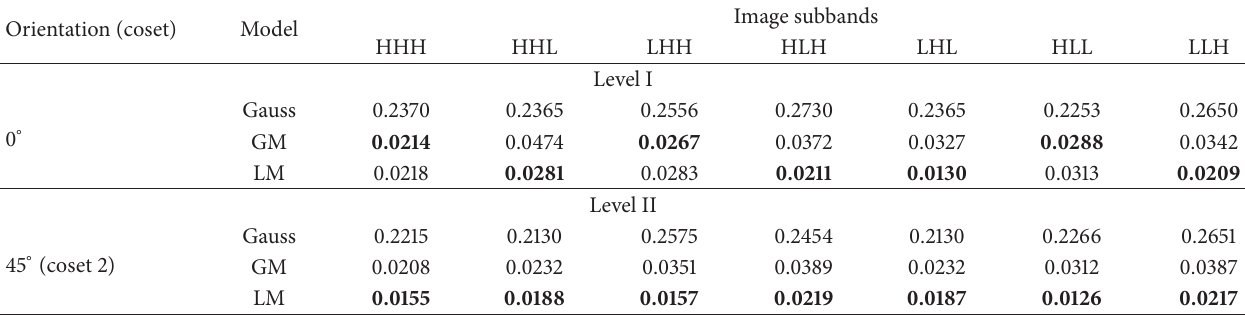
Table 1: The cumulative distribution distance 𝐷 values of Gaussian, Gaussian mixture, and Laplacian mixture PDFs, respectively, and the corresponding parameters estimated from two level subbands along two directions of Couple